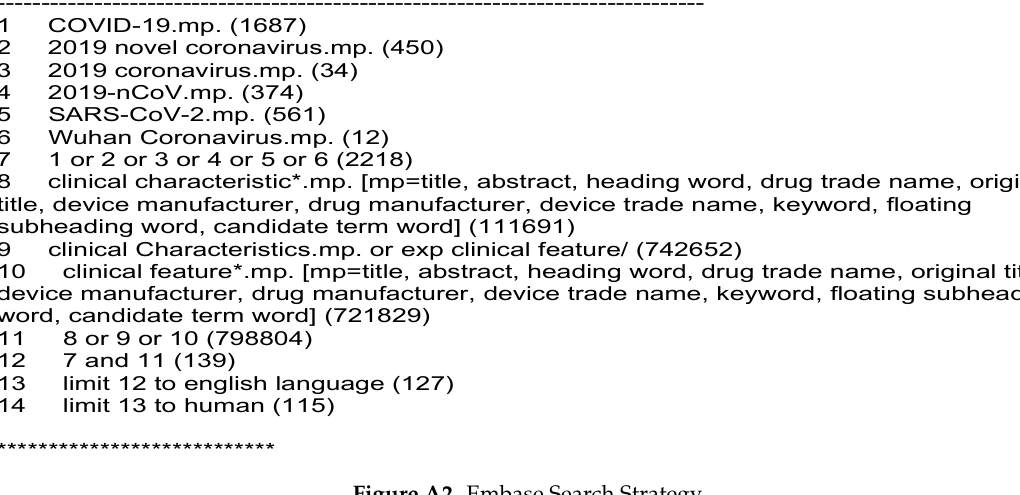
Figure A2. Embase Search Strategy.